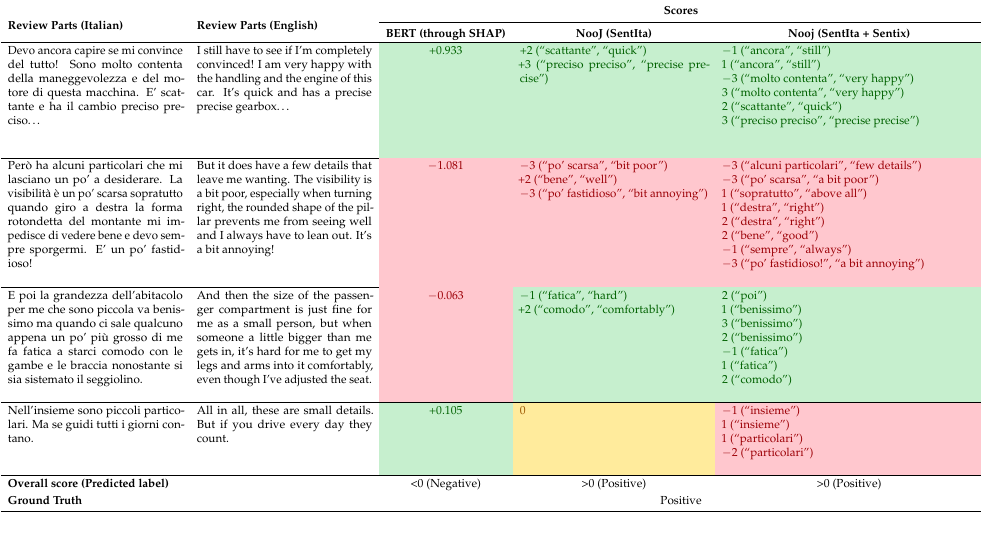
Table 12. Only NooJ detects them correctly. Example